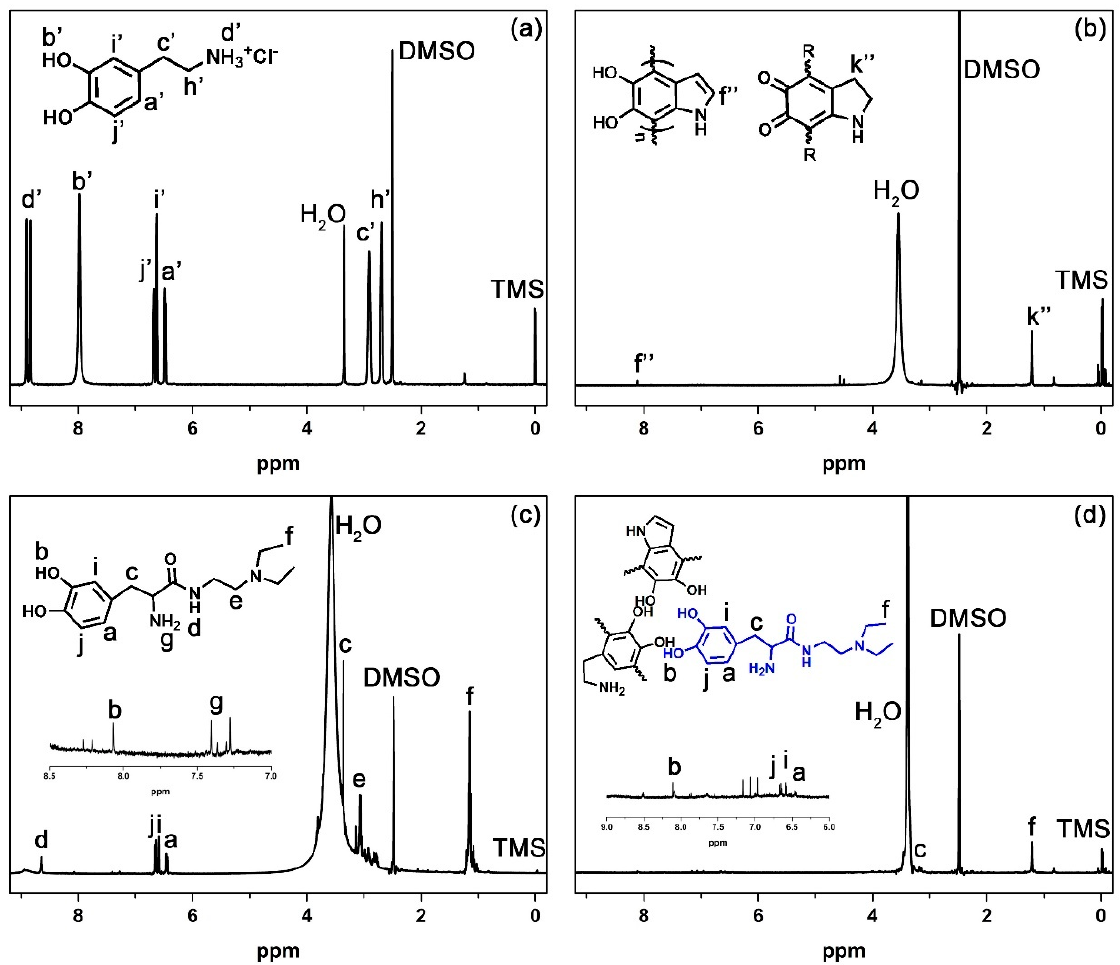
Figure 3. 1 H-NMR spectra of ( a ) dopamine, ( b ) PDANPs, ( c ) N-Dopa and ( d ) N-Dopa copolymerized polydopamine nanoparticles (amino-Fe-PDANPs).